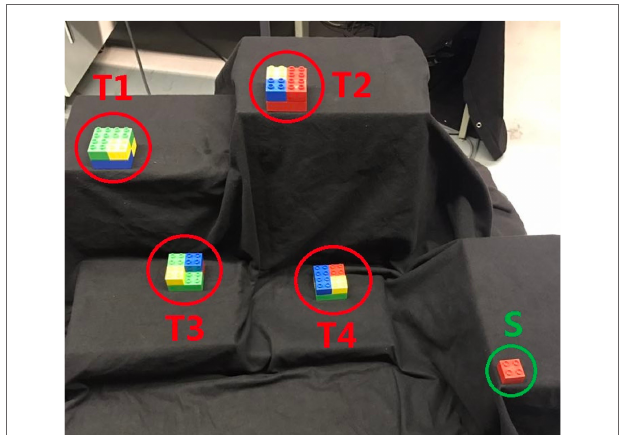
FIGURE 9 | Experiment for the hybrid online prediction framework. S is the starting position and T1 to T4 are the four target regions. Each region consists of four possible placing positions as four corners of a square for the LEGO